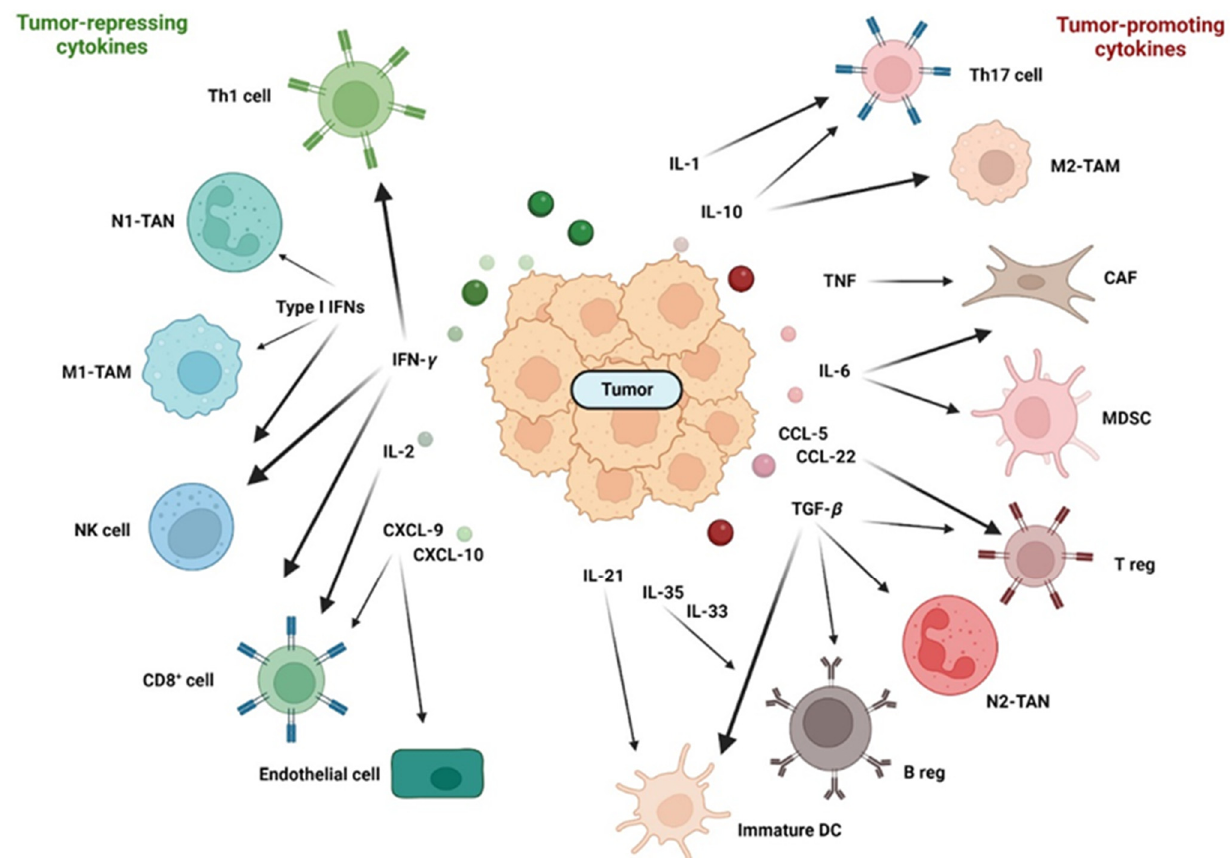
Figure 4. The relationship between tumor repressing and tumor-promoting cytokines in the TME. Stress, bacteria and their components that cross disrupted barriers or death of tumor cells induce inflammation with increased expression of several cytokines and chemokines. Depending on the composition of the cytokine/chemokine mixture, a tumor microenvironment that is more immunosuppressive and tolerogenic ( right ) or more tumor suppressive ( left ) is induced.